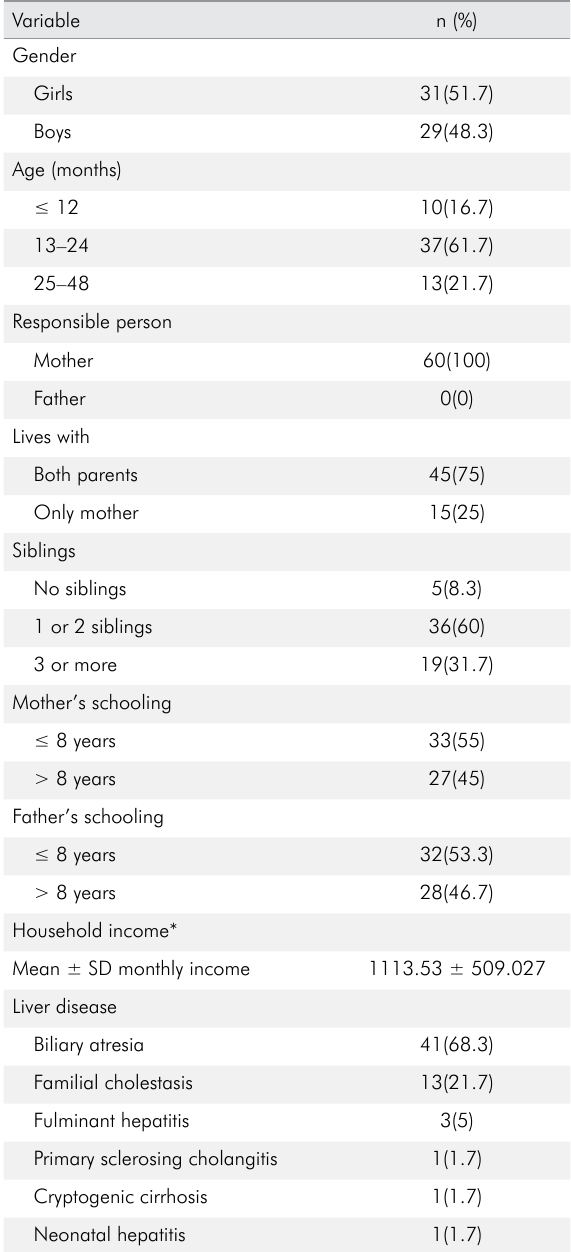
Table 1. Socioeconomic/demographic characteristics and liver disease diagnoses of pediatric liver transplant candidates (n =